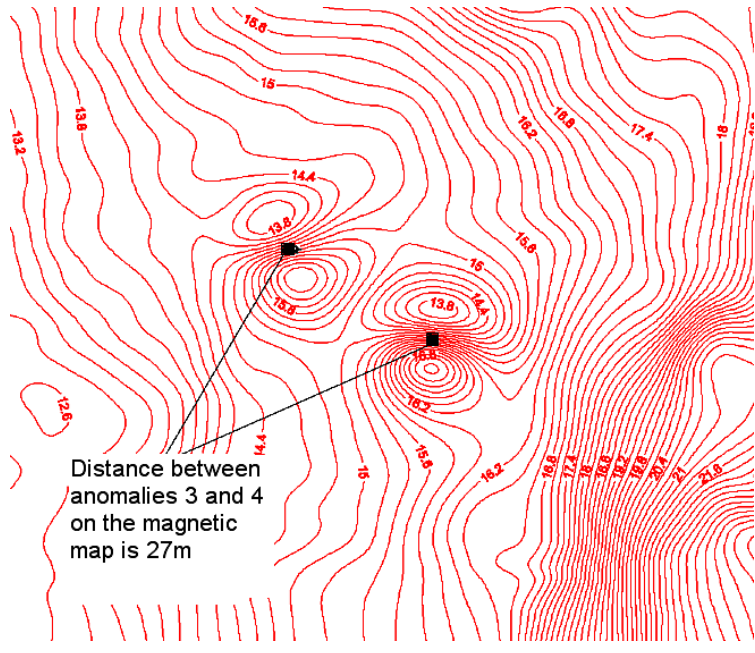
Figure 9. Anomalies 3 and 4 on contour map. The distance on the map is 27